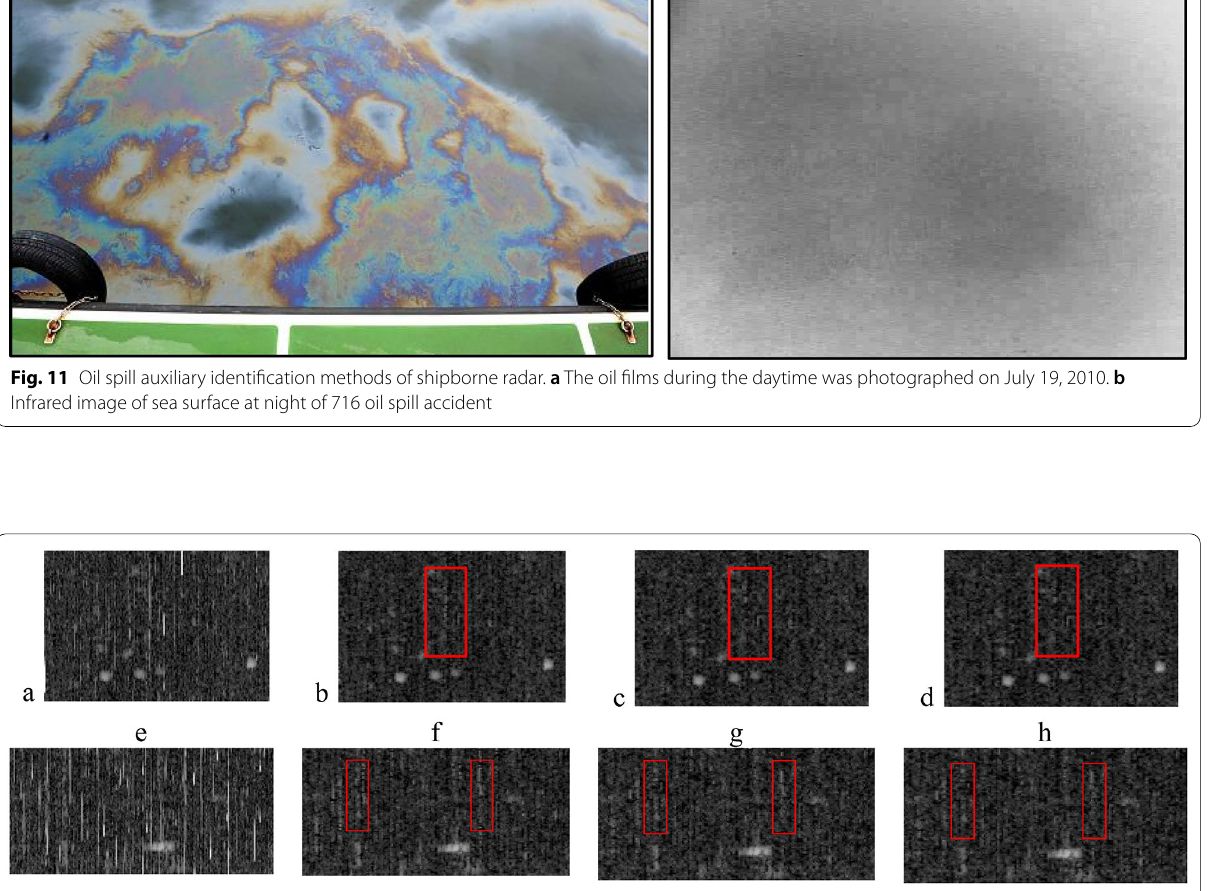
Fig. 12 Noise reduction results of co-frequency interferences. a , b Were the (100:200, 320:470) and (320:410, 880:1070) of Fig. 5b. b , f Were the results of the Laplace operator. c , g Were the results of an improved Prewitt operator. d , h Were the results of our improved Sobel operator